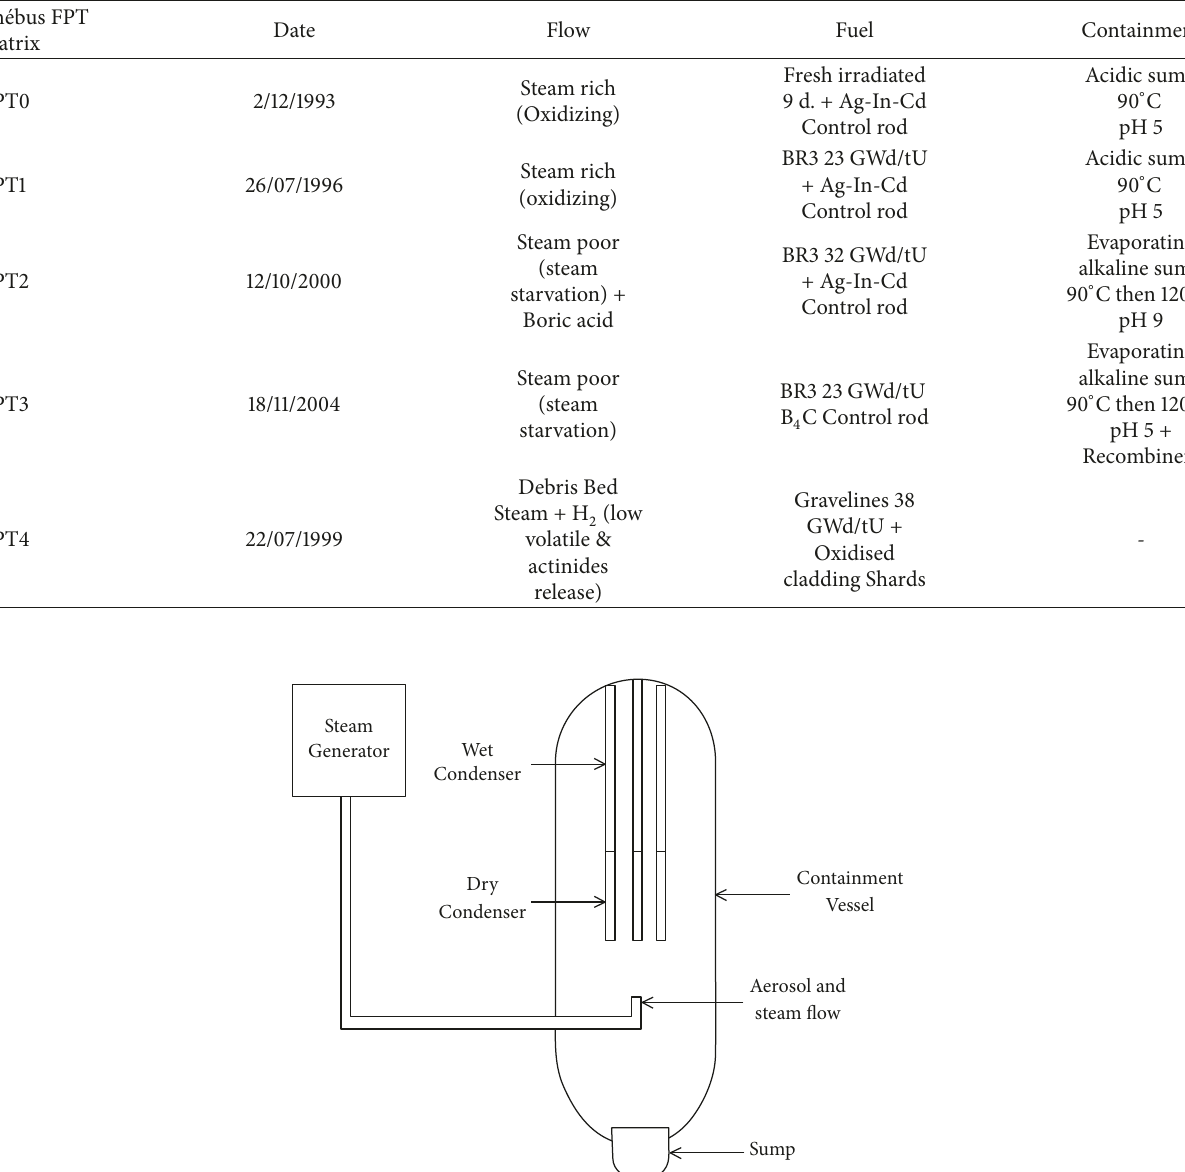
Table 1: Ph´ebus FPT matrix [5, 22].